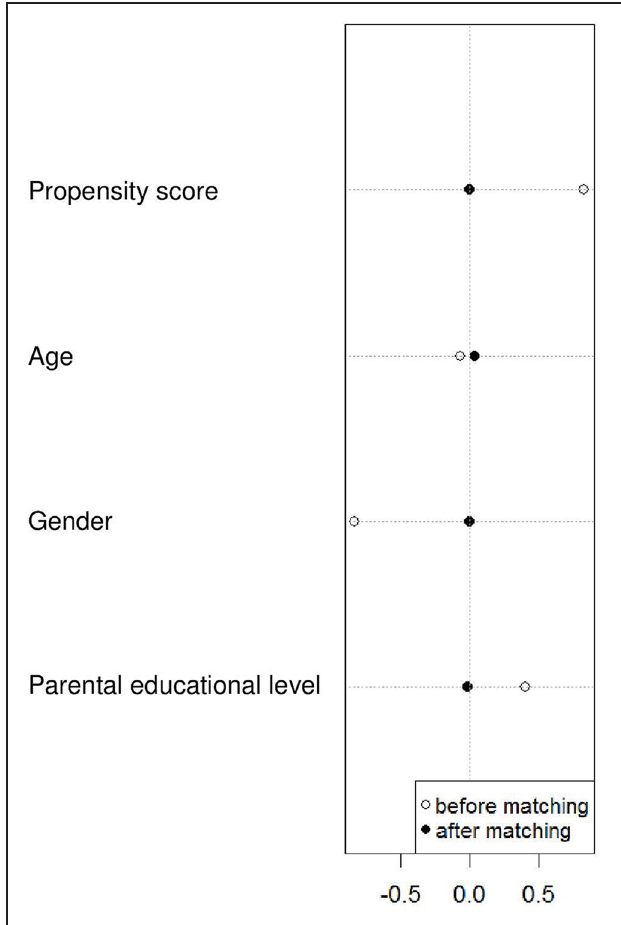
FIGURE 1 | Standardized mean differences between the gifted and non-gifted students on the covariates before and after 1:1 nearest neighbor caliper ( c = 0.1) matching without